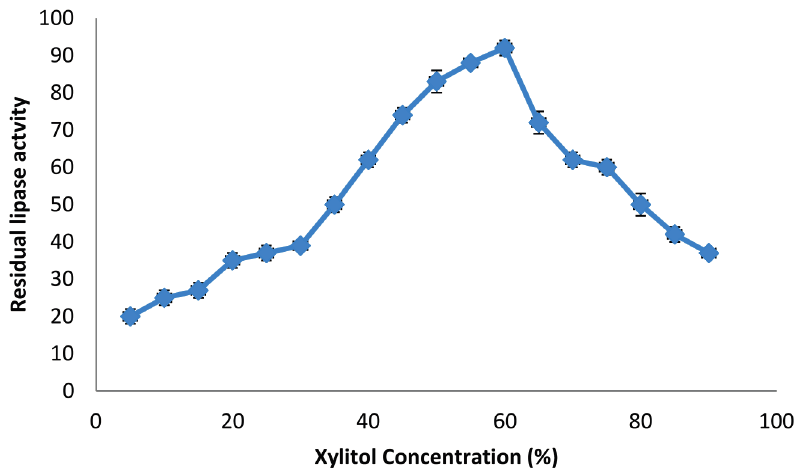
Figure 2. The effect of various concentrations of xylitol on the lipase activity. The lipase was mixed with different concentrations of xylitol from 5% to 90%. The activity of the enzyme in the presence of xylitol was then